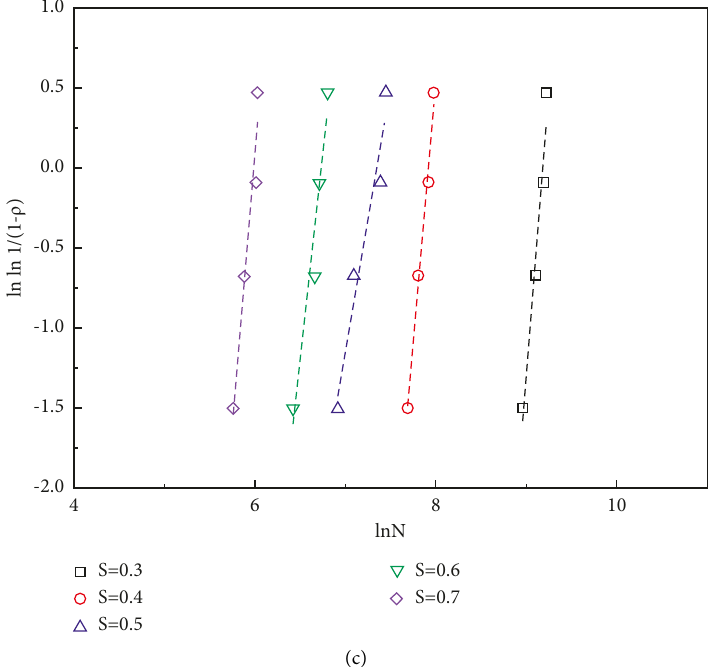
Figure 7: Weibull fitting results of the SMA-13 mixture with skeleton dense gradation. (a) Marshall method. (b) SGC method. (c) VTM method.